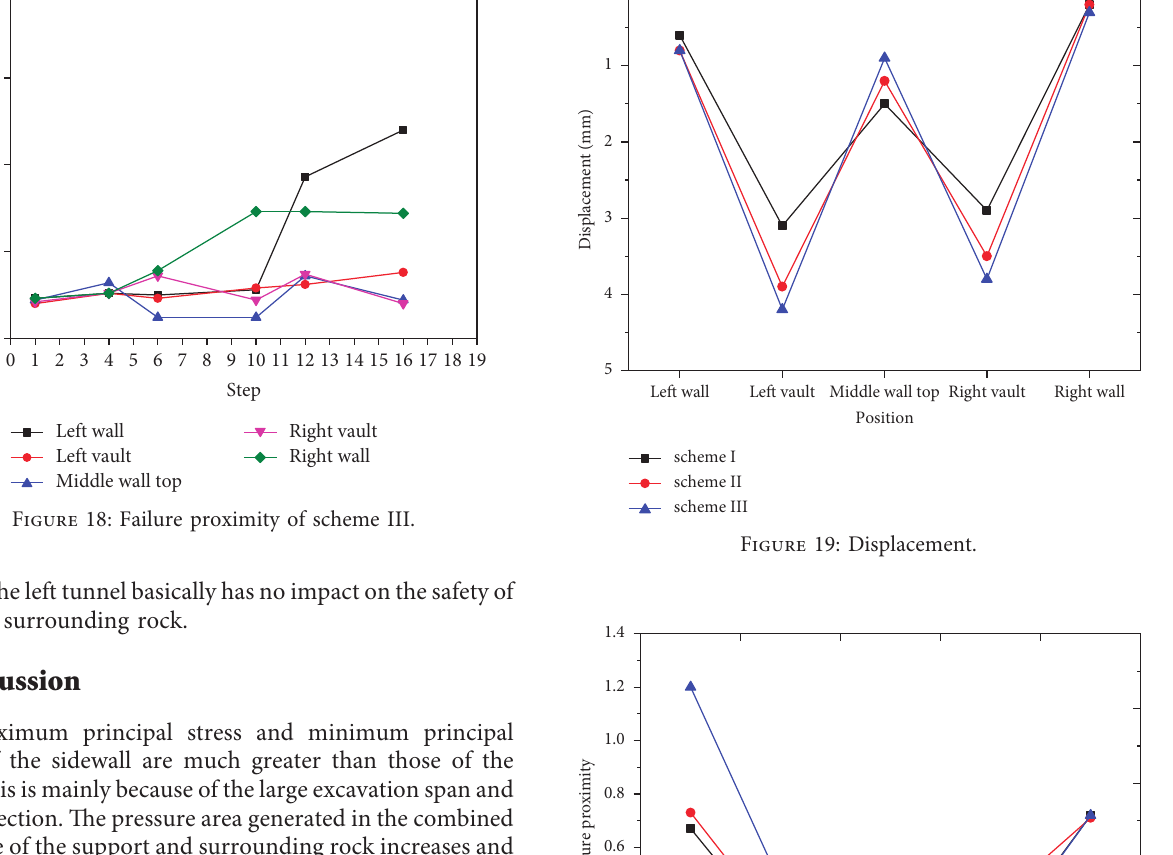
Left vault Middle wall top Right vault Right wallLeft wall